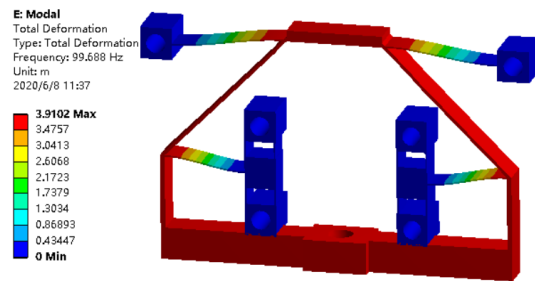
Figure 6. First modal shape of ACPM.